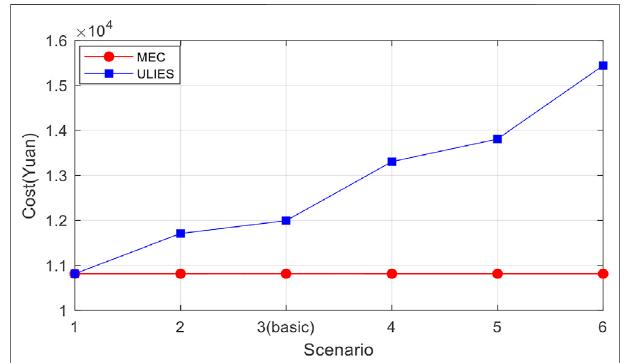
FIGURE 10 | Results of satisfaction-based pro fi t